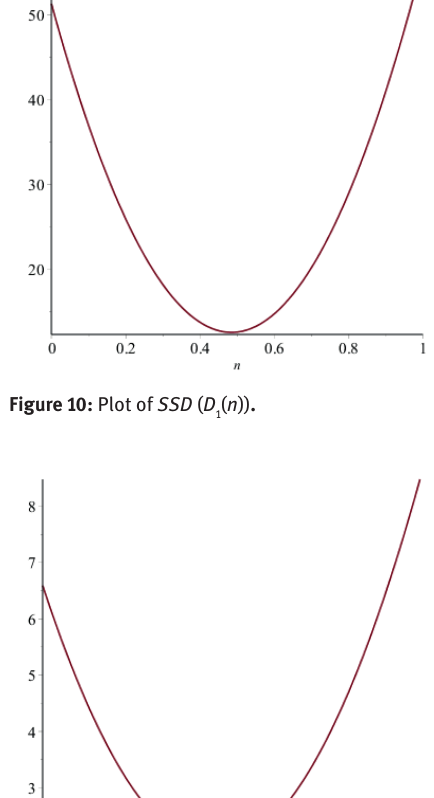
Figure 11: Plot of H ( D